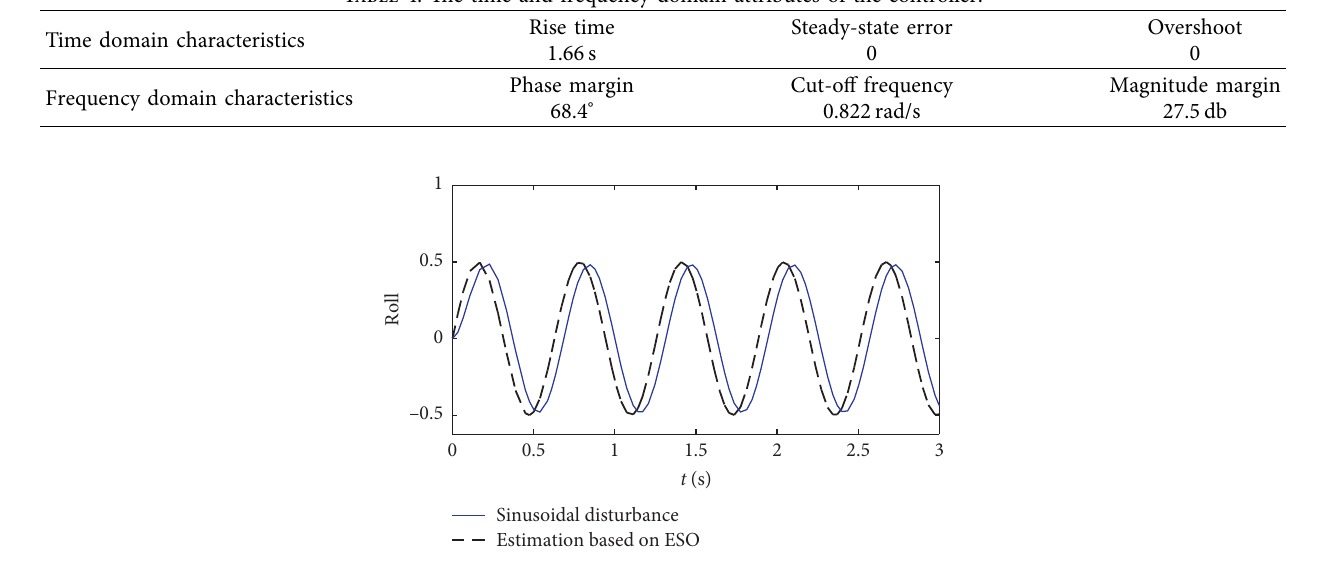
Figure 11: Disturbance estimation based on